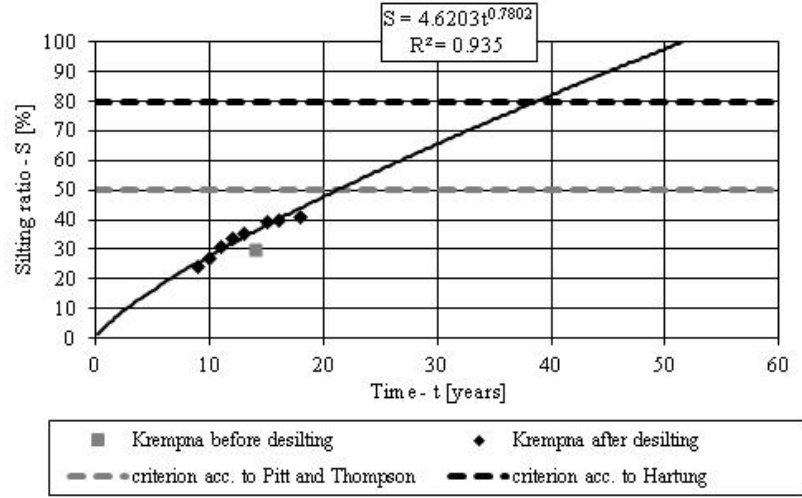
Figure 4. Correlation relationship between the silting rate of reservoir at Krempna and its time of